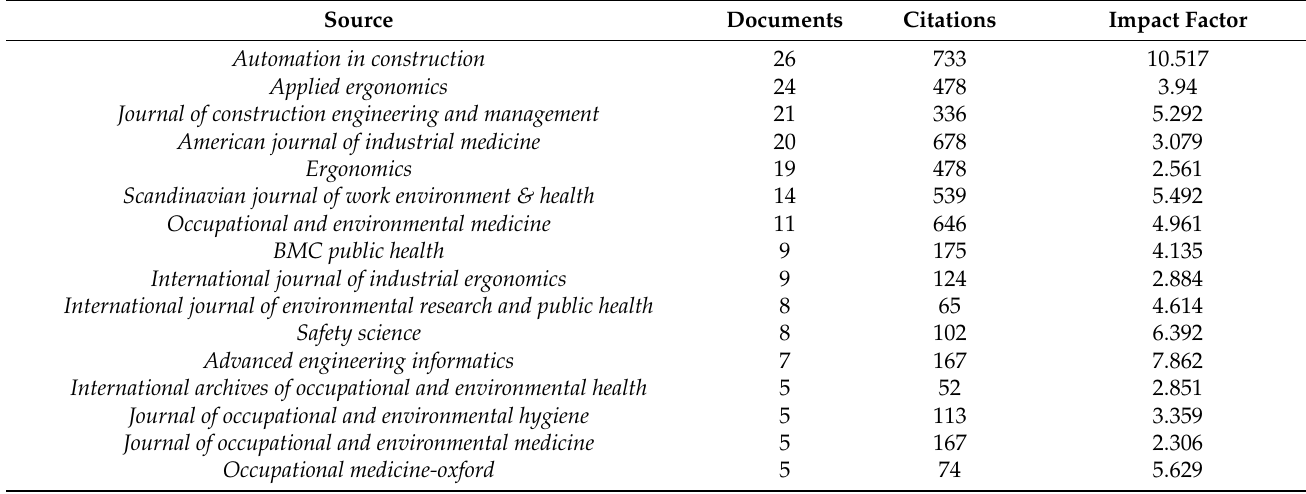
Figure 6. Source analysis. Table 3. List of journals (descending order according to documents).